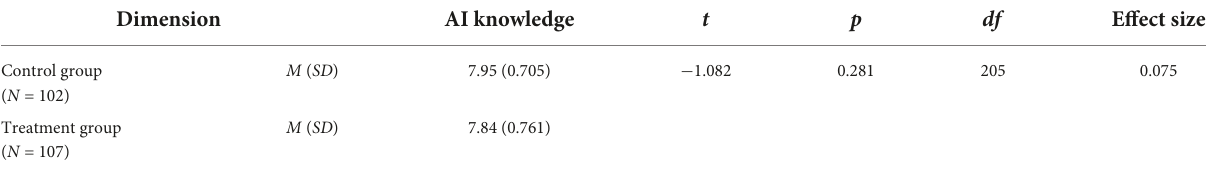
TABLE 3 Means and standard deviation of students’ learning achievement.